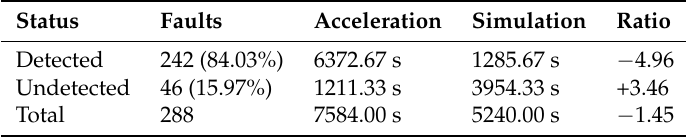
Table 3. M-AC/DC performance according for the CA